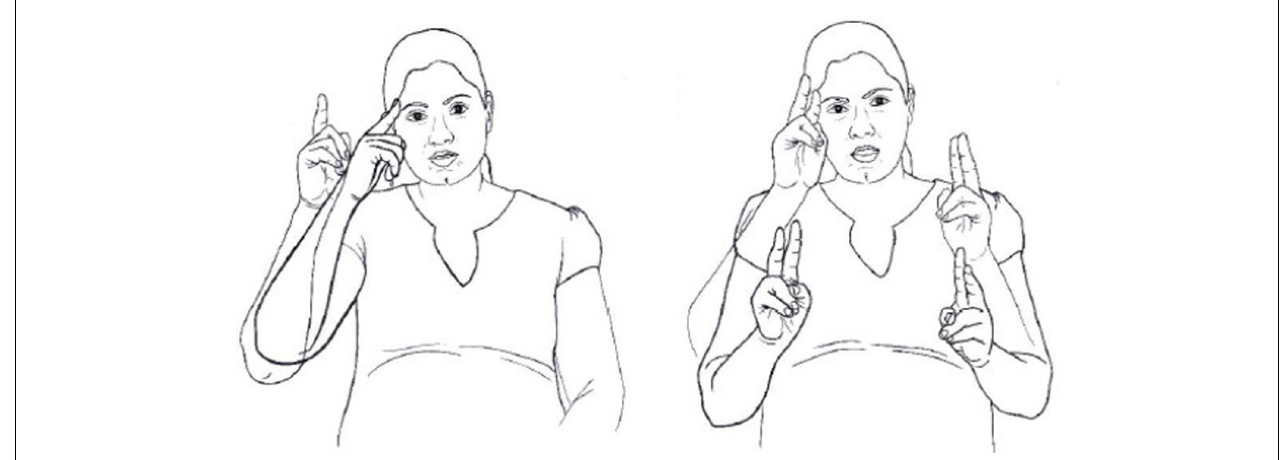
FIGURE 5 | Compound-like constructions that include body part in ISL: HEAD + STOP ‘to have a